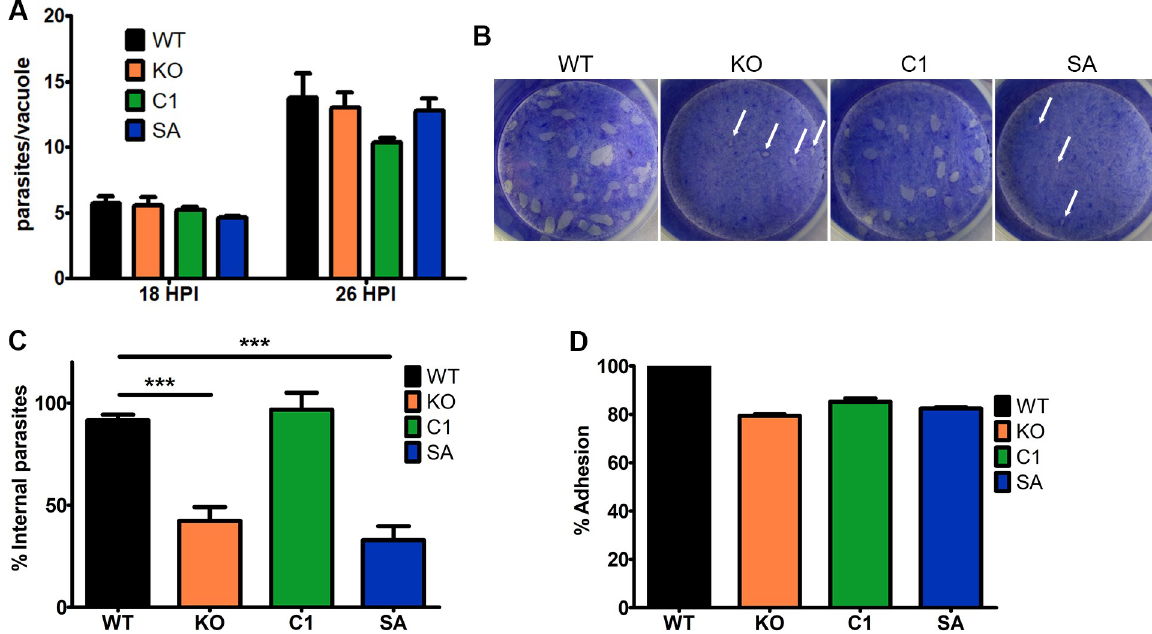
Fig 4. TgPL3 is critical for invasion but not attachment. (A) Triplicate monolayers of HFFs were infected with 3.4 x 10 4 T . gondii parasites. At 18 or 26 hours post infection, tachyzoites per vacuole were scored in at least 100 randomly encountered vacuoles per replicate. Average tachyzoites per vacuole is shown at each time point. P value was nonsignificant in a two tailed t-test compared to WT. (B) 9 days post infection, HFF monolayers were stained with crystal violet to reveal T . gondii plaque formation. White arrows indicate the small plaques created by the KO and SA parasites. (C) The percentage of parasites that were successfully able to invade the host cell was determined using the red/green invasion assay [21]. Four independent experiments were performed in triplet, and the combined results are shown here. ��� p < 0.0001. (D) The percentage of parasites that were attached to glutaraldehyde fixed host cells was examined but no significant differences were seen. Shown here the combined results from two independent experiments performed in triplet.